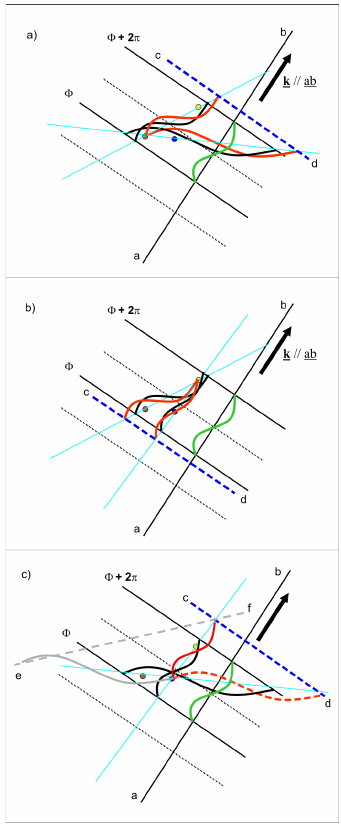
Fig. 4. Part B of the geometrical description of the determination of the real horizontal wavelength. The derived horizontal wavelength for each reference point (the wavelength for part Ab is displayed in a ; the wavelength for part Ac in b ; and the wavelength for part Ad in c